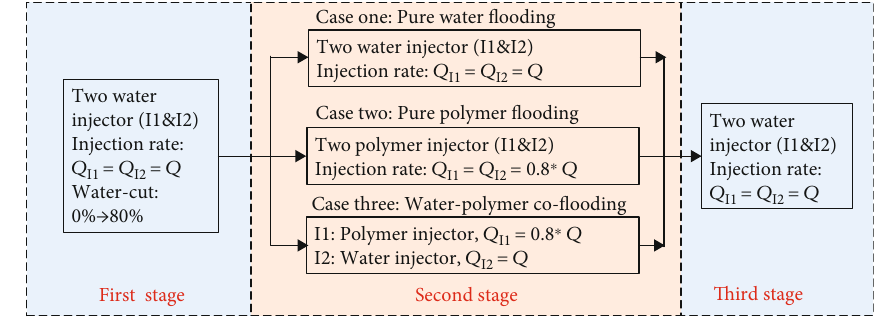
Figure 3: Stage division and simulation schemes.